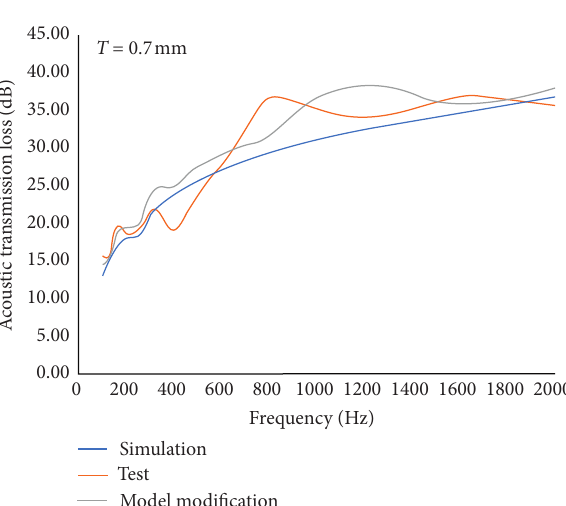
Figure 7: Validation of the front coaming model with a thickness of 0.7mm.